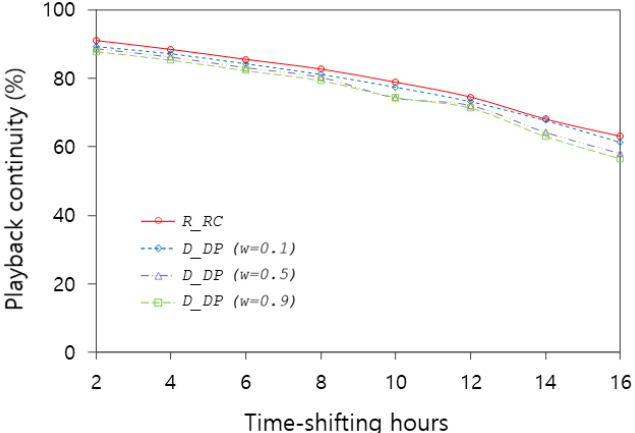
Figure 9. Comparison of playback requests between D _ DP and R _ RP in distribution 2 with a 150 s buffer.